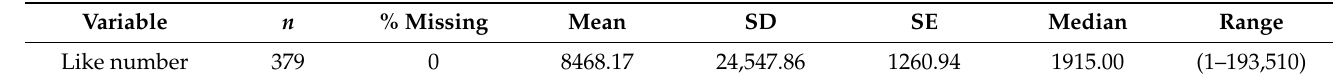
Table 7. Descriptive statistics of the number of likes.